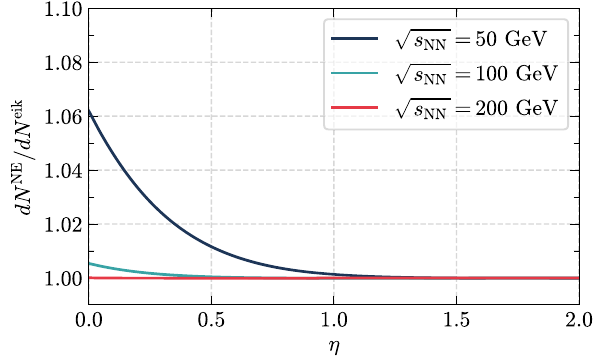
Fig. 5 Ratio of the non-eikonal single gluon spectrum, given in Eq. (4.6), with respect to the eikonal one as a function of the pseudora- pidity of the produced gluon for three values of